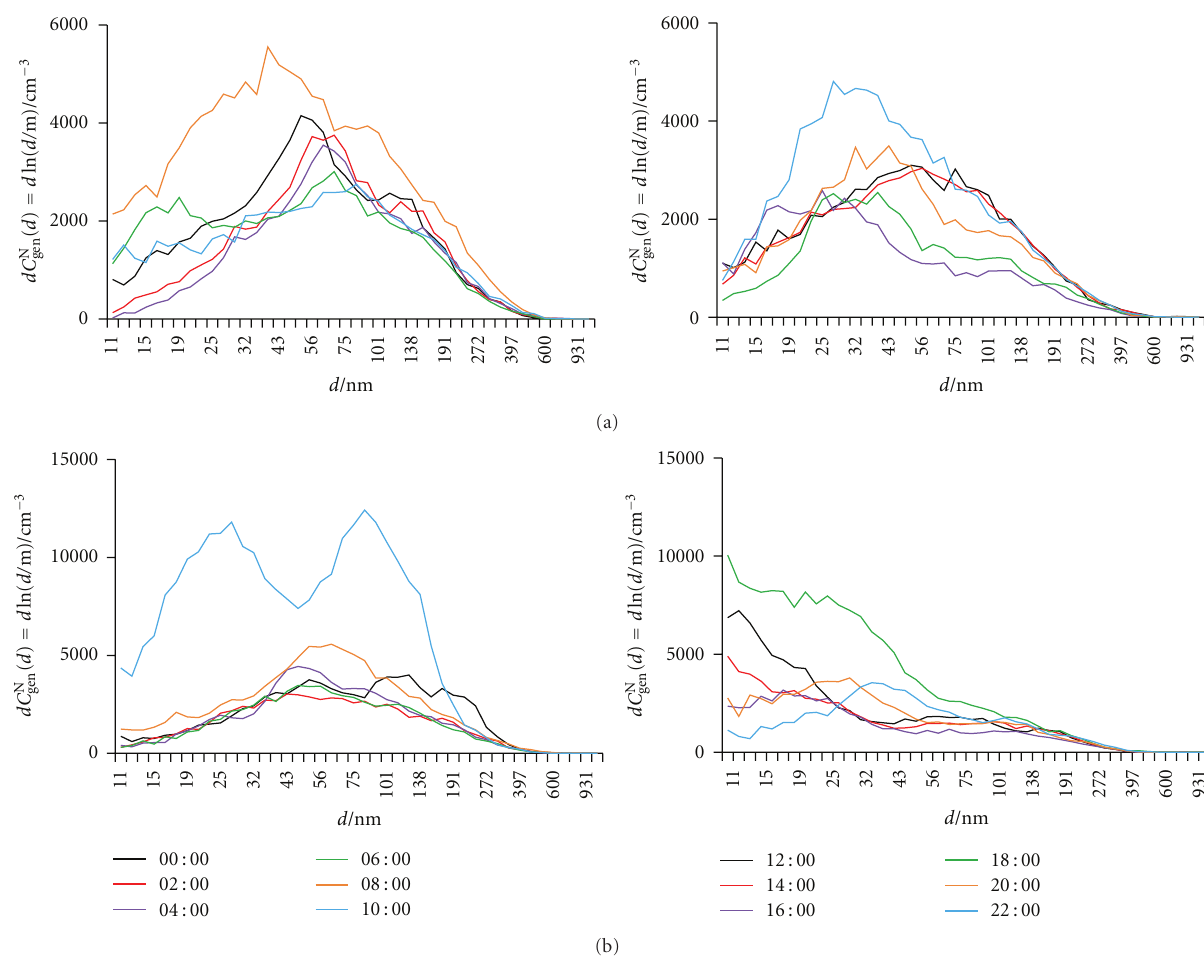
Figure 7: Number particle size distribution (d C N